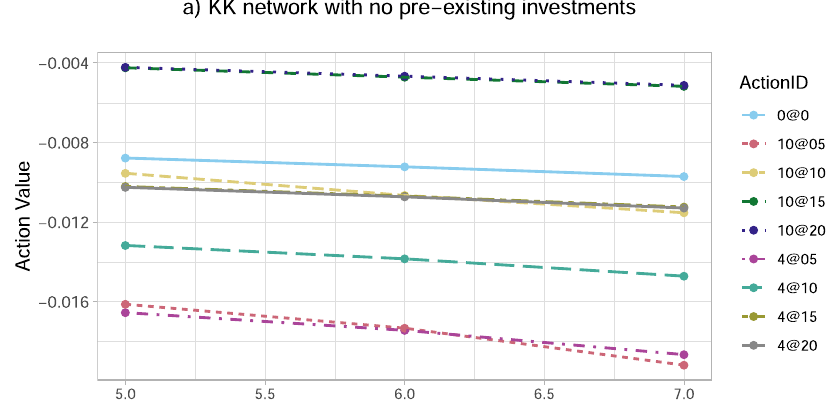
etc. a The algorithm feels the network structure and suggests to invest in node 4 (leading to smaller loss) rather than node 10. b In case the government had pre- viously invested in node 10, the government needs to protect its investment by optimally risking an additional investment in node